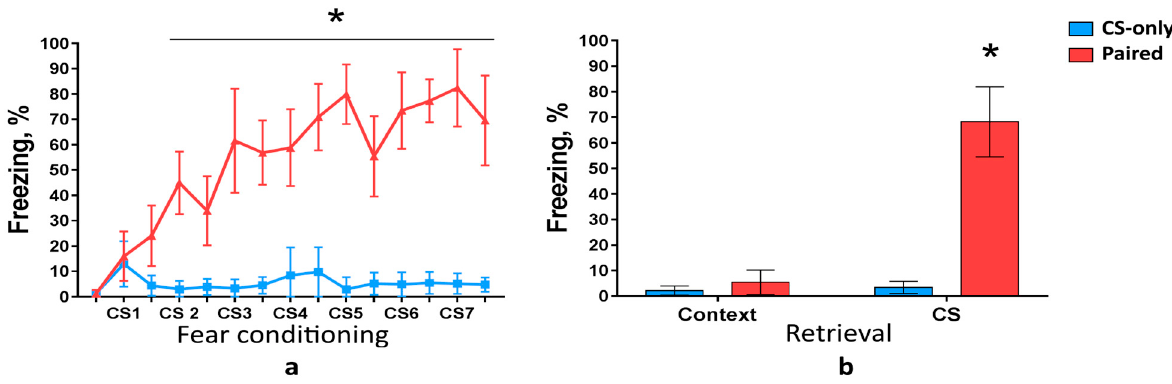
Figure 1. Freezing during ( a ) fear conditioning (FC) and ( b ) memory retrieval 24 h after the FC (mean, 95% confidence interval (CI)). Fear response increased during training only in the Paired group (* p < 0.0001, two-way ANOVA). Trained animals froze more than CS-only group during conditioned stimulus (CS) memory retrieval (* p < 0.0001, two-way ANOVA with post hoc Tukey test).